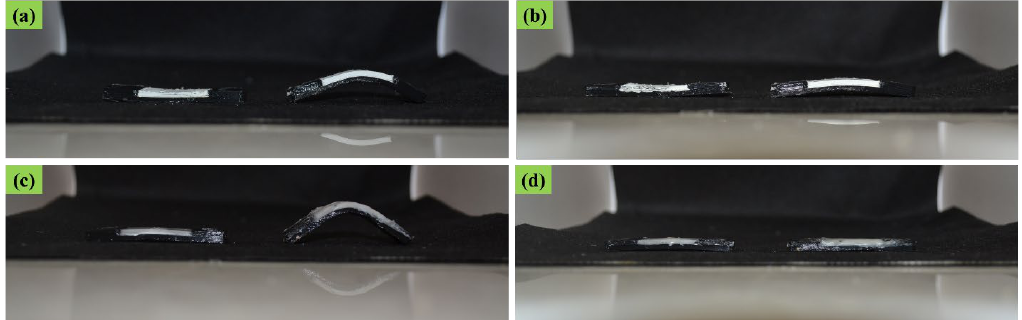
Figure 7. Shape memory properties in the last shape memory cycle: ( a ) fixity and ( b ) recovery for the ABS–TPU composite, and ( c ) fixity and ( d ) recovery for the PCL–TPU composite.